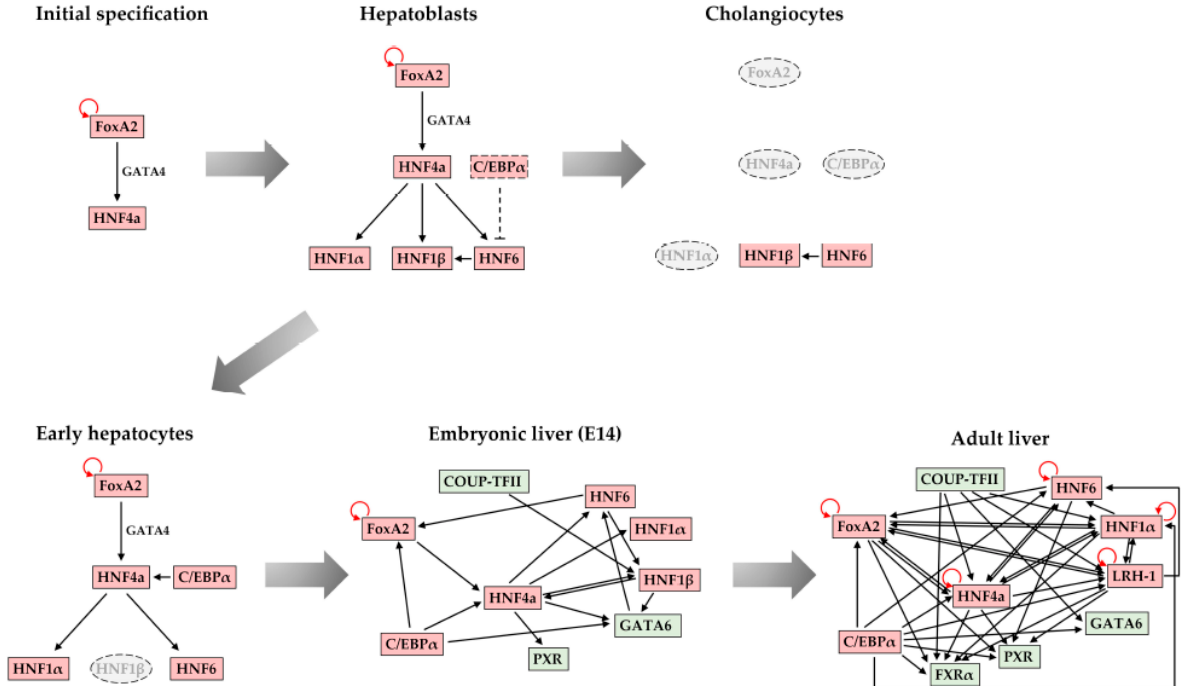
Figure 3. Schematic diagram of the transcription factor network during liver development. During the initial specification, early embryonic, and hepatoblast stages, the cross-regulatory interactions are limited and are dominated by single-input and double-input motifs. Hepatoblasts are bipotential cells, which give rise to hepatocytes and cholangiocytes. The loss of C/EBP α in cholangiocytes leads to the increased expression of HNF6 and HNF1 β . The regulatory interactions are reorganized in hepatocytes and form a network, which becomes more complex as differentiation proceeds to the adult stages. The increased number of transcription factors on the individual promoters confer functional redundancy and network stability.